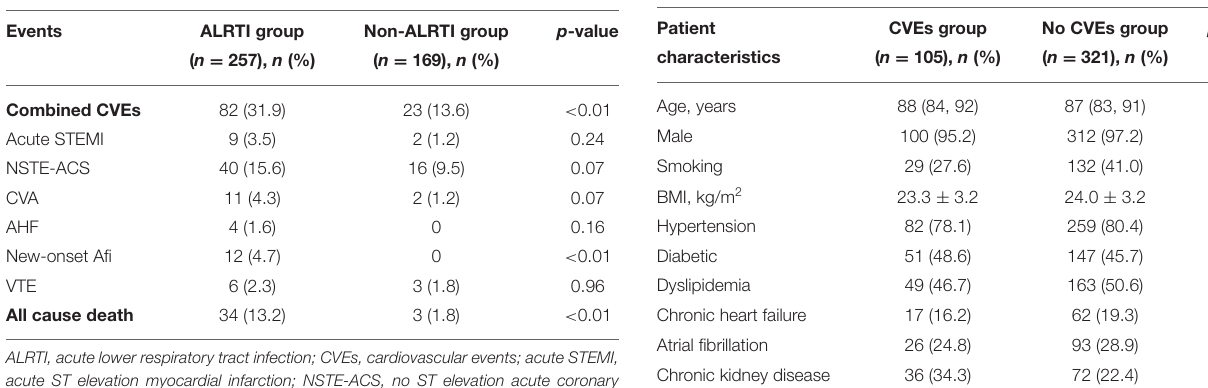
TABLE 3 | Comparison of characteristics in patients with or without CVEs at